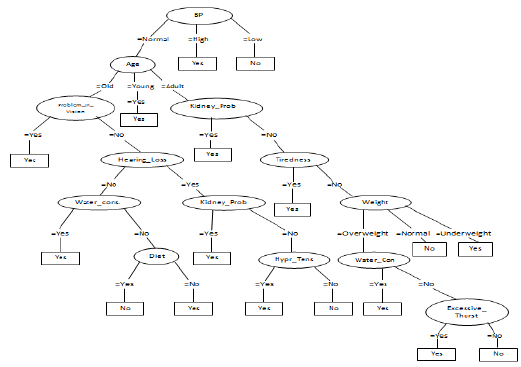
Figure 3. C4.5 decision